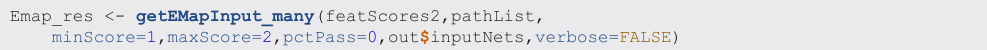
Visualize pathway features as an enrichment map. An enrichment map is a network-based visualization of path- way connectivity and is used in netDx to visualize themes in predictive pathway-based features 5 . It is used in conjunction with the AutoAnnotate Cytoscape app to identify clusters, and apply auto-generated labels to these 6 . Use to create the input that helps generate the enrichment map in getEMapInput_many()